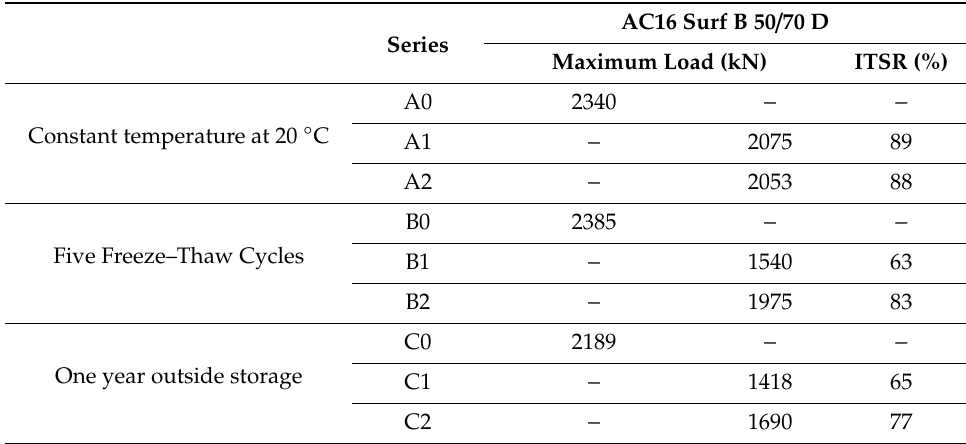
Table 6. Indirect tensile strength and water sensitivity.